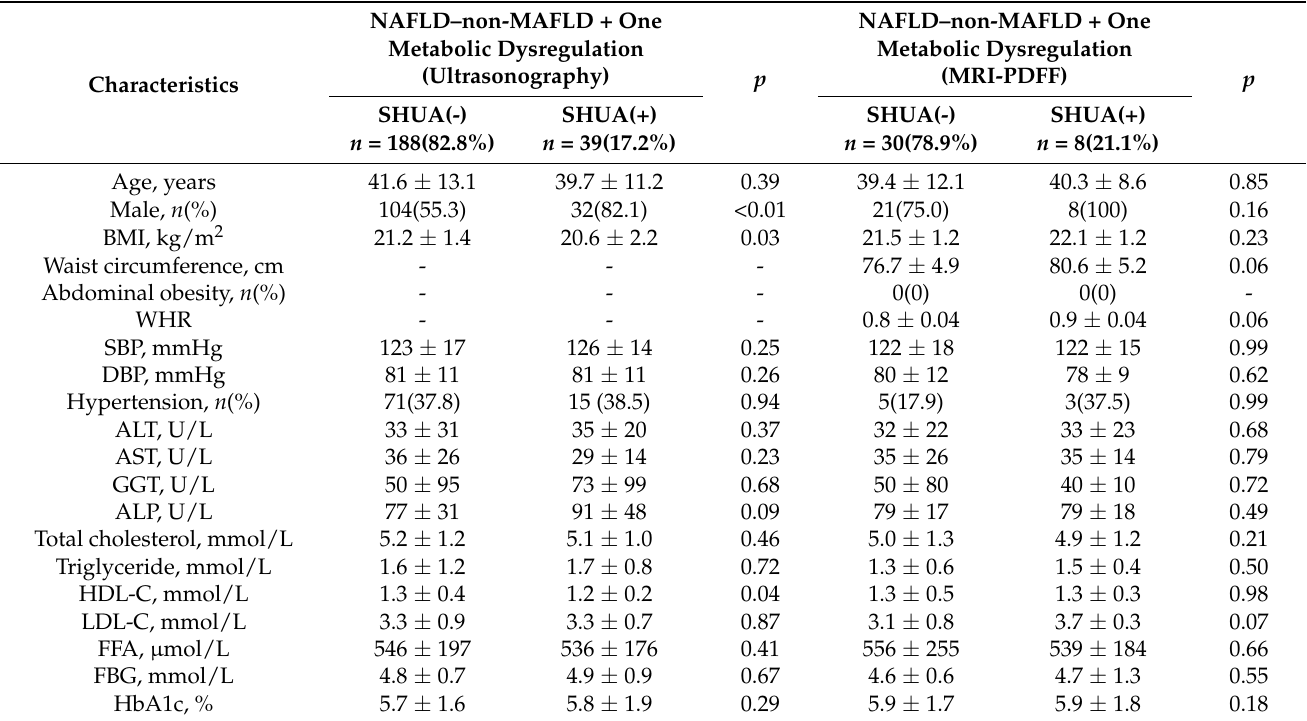
Figure 3. Distribution of HUA and SHUA in all subjects: ( A ) all, ( B ) male, ( C ) female, ( D ) all, ( E ) male, and ( F ) female. Table 4. Comparisons among lean NAFLD–non-MAFLD conditions that coexist one metabolic dysregulation with